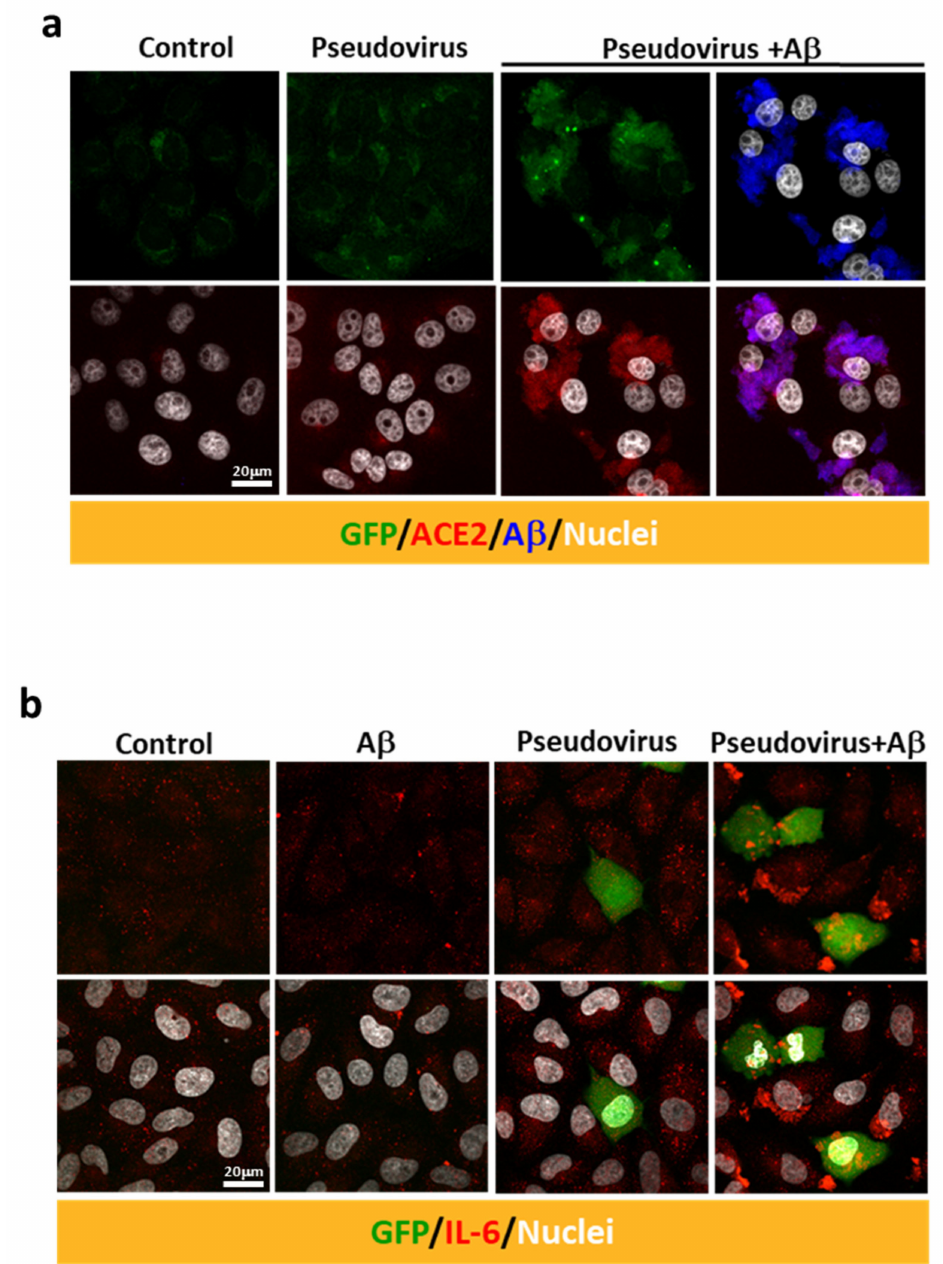
Figure 4. A β 1-42 increases the intracellular immuno-reactivity of IL-6 in a SARS-CoV-2 pseudovirus infection model. ( a ) Immuno-reactivity of endogenous ACE2 (in red) was detected at relatively low levels in the controls. Treatment with A β 1-42 (10 µ g/mL) and SARS-CoV-2 pseudovirus increased the expression of ACE2 (red, lower panel) as well as the co-localization of ACE2 and A β 1-42 (in blue) in Vero E6 cells. ( b ) Intracellular IL-6 expression was evaluated by confocal microscopy after infection with SARS-CoV-2 pseudovirus in the presence or the absence of A β 1-42 (50 µ g/mL) in human A549 alveolar epithelial cells. GFP (in green) was abundantly expressed in a few cells 17 h post-infection. Minimal intracellular IL-6 immuno-reactivity was observed in cells receiving either A β 1-42 or SARS-CoV-2 pseudovirus alone. In contrast, infection with SARS-CoV-2 pseudovirus in the presence of A β 1-42 increased intracellular IL-6 immuno-reactivity (in red). Scale bars: 20 µ